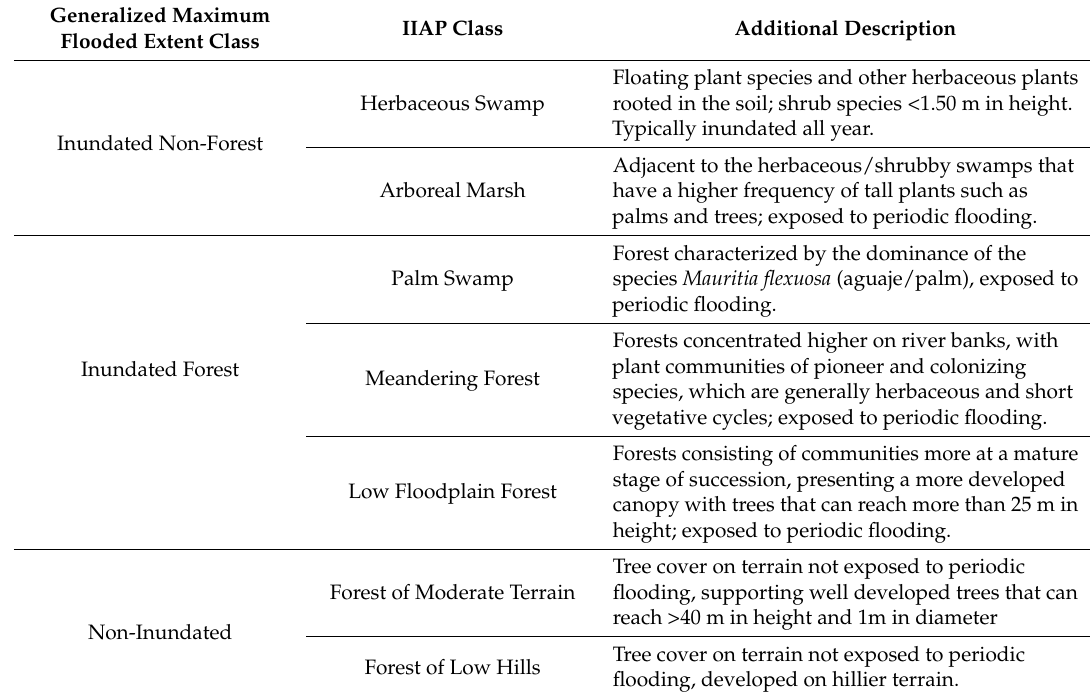
Table A3. Description of IIAP land cover classes and the corresponding class used for